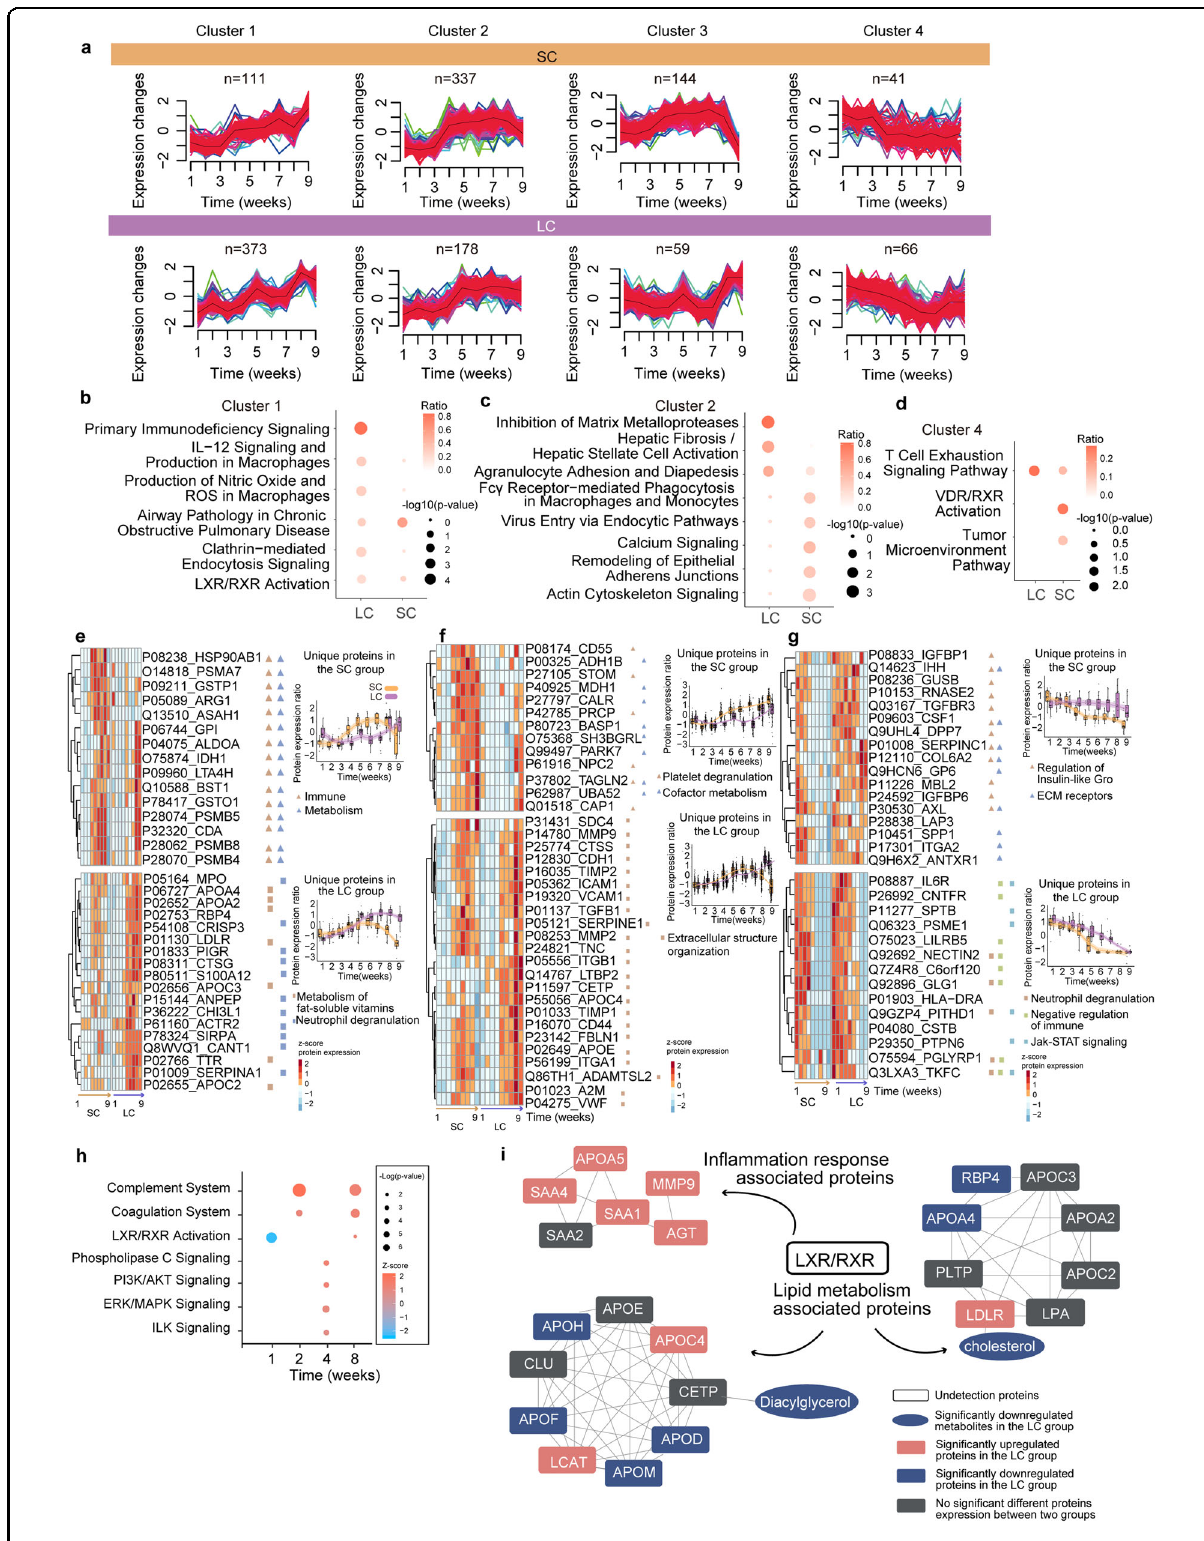
Fig. 3 (See legend on next